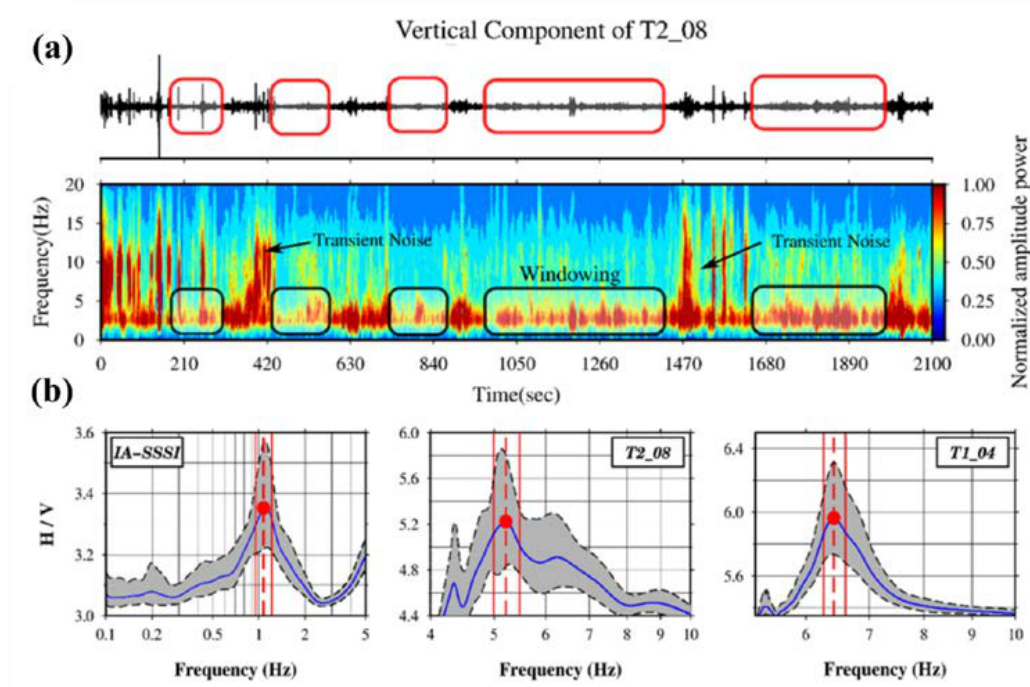
Fig. 3: (a) Example recording of the vertical component in 2100 s at site T208 and the spectrogram with a frequency range of 0–20 Hz. (b) The selected windowing is marked by a frequency of <5 Hz, while the transient noise is marked by a sudden peak. (b) Example of the H/V graph results from IA-SSSI as the permanent sensor and T2_08 and T1_04 as the temporary sensor.